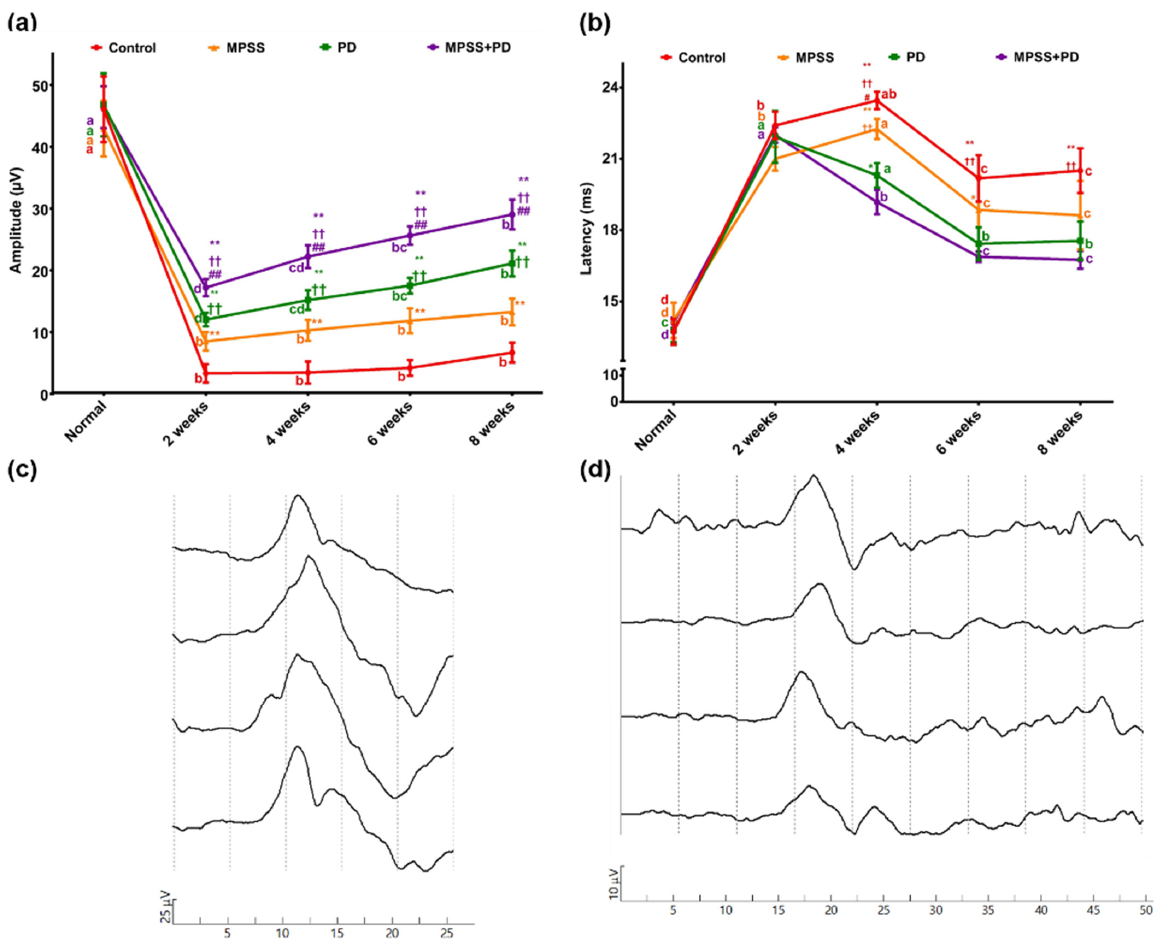
Figure 3. The findings of spinal SSEPs were recorded from sites along the vertebral column after tibial nerve stimulation. ( a ) Quantitative analyses illustrated the changes in baseline-to-peak amplitude ( µ V) Data were represented as mean ± SD. At the same time point, ** denotes significance compared with the control group at p <0.01, †† denotes signi fi cance compared with the MPSS group at p <0.01 and ## denotes significance compared with the PD group at p < 0.01. Meanwhile, within the same group, different letters indicate significant differences p < 0.05. ( b ) Peak latency (ms) of SSEPs during follow-up in all groups. Data were represented as mean ± SD. At the same time point, * denotes significant latency compared with the combination group at p <0.05, ** denotes significant latency compared with the combination group at p <0.01, †† denotes signi fi cant latency compared with the PD group at p <0.01 and # denotes significant latency compared with the MPSS group at p < 0.05. Meanwhile, within the same group, different letters indicate significant differences p < 0.05. ( c ) SSEPs traces were recorded from the combination group before (at baseline) and ( d ) after 8-weeks of induced SCI. Traces were obtained from tibial nerve stimulation. Peak latency (ms) and baseline-to-peak amplitude (µV) measurements were obtained from the first prominent negative peak. Gain = 25 µV/div ( c ) or 10 µV/div ( d ); sweep speed = 5ms/div ( c , d ). Data from different groups were compared to normal preoperative values (baseline).